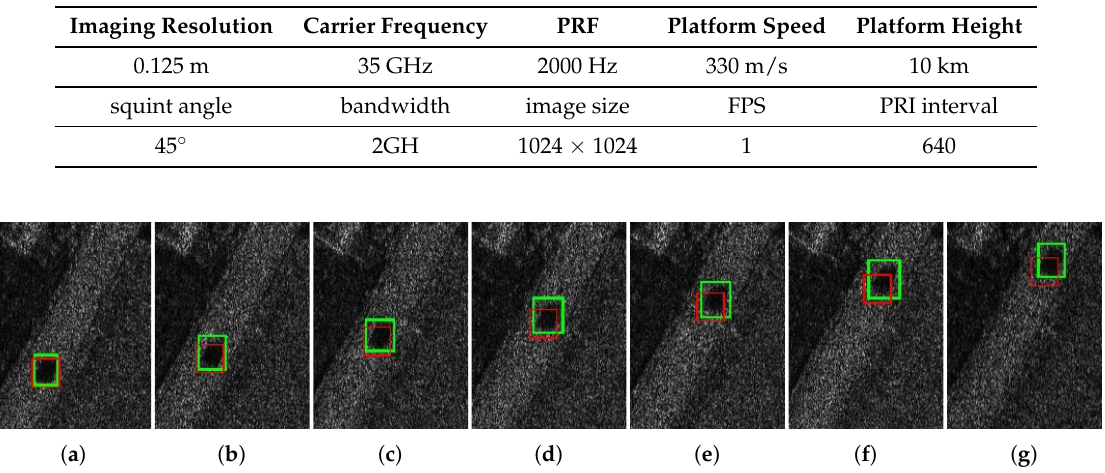
Figure 13. Partial tracking results of Minimum Output Sum of Squared Error (MOSSE) of simulated video-SAR data. Green rectangles are the true trajectories of the target, and red rectangles represent tracking results. ( a – g ) are the corresponding results of frame 1, 10, 20, 30, 40, 50 and 60, respectively.